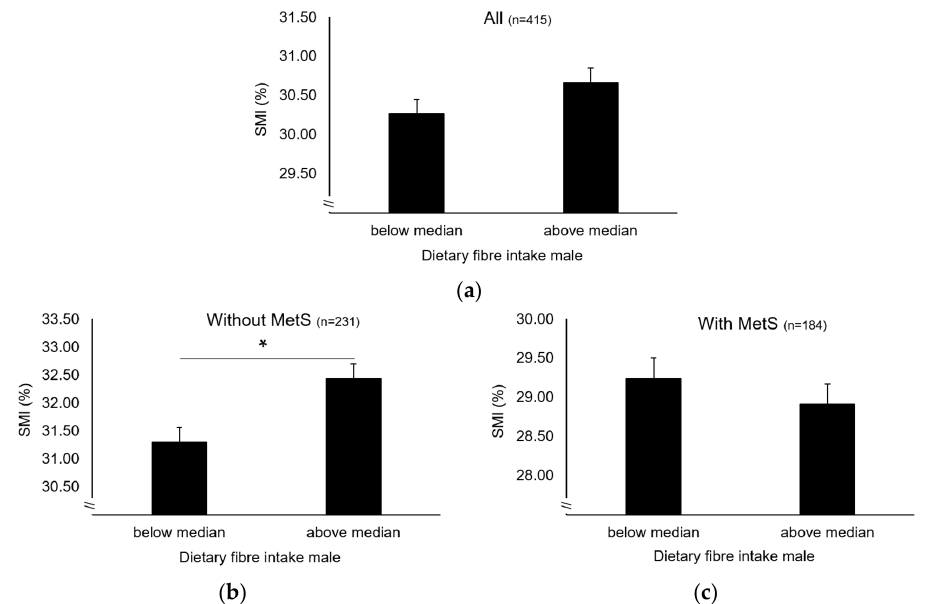
Figure 2. Skeletal muscle mass in older men below and above median FI ( a ) and stratified by MetS ( b and c ). Data are estimated marginal means ± SEM adjusted for age, recruiting centre and total energy intake (and prevalence of MetS in all). SMI, Skeletal Muscle Mass Index. * p < 0.05. There was no main effect of FI on the physical function parameters, including SPPB score and handgrip strength and, no interactions between FI and MetS were